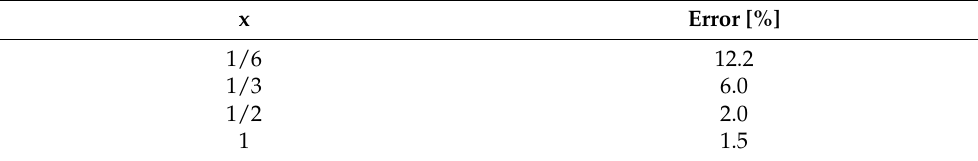
Table 2. Error between measured T DLY and simulated T DLY at each